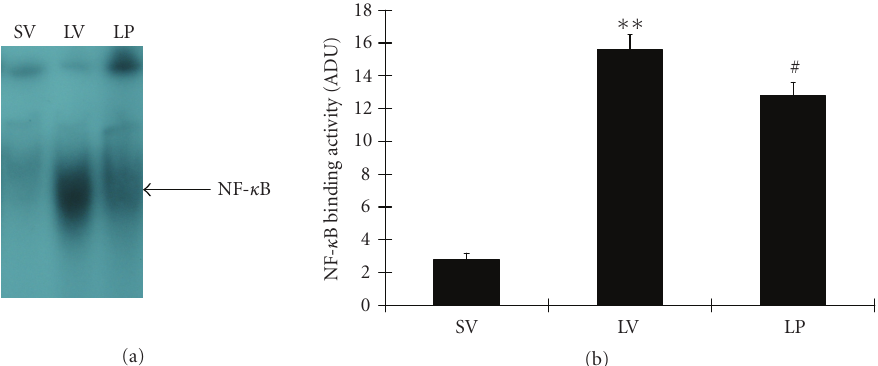
Figure 1: NF- κ B activity in the ileum tissue in SV group (sham + vehicle, n = 6), LV group (lesion + vehicle, n = 6), and LP group (lesion + progesterone, n = 6). (Upper) EMSA autoradiography of NF- κ B DNA binding. (Bottom) Levels of NF- κ B DNA binding activity quantified by computer-assisted densitometric scanning and expressed as an arbitrary densitometric units (ADU). As compared with SV group, NF- κ B binding activity measured by EMSA was significantly increased in LV group. Compared to LV group, progesterone significantly suppressed